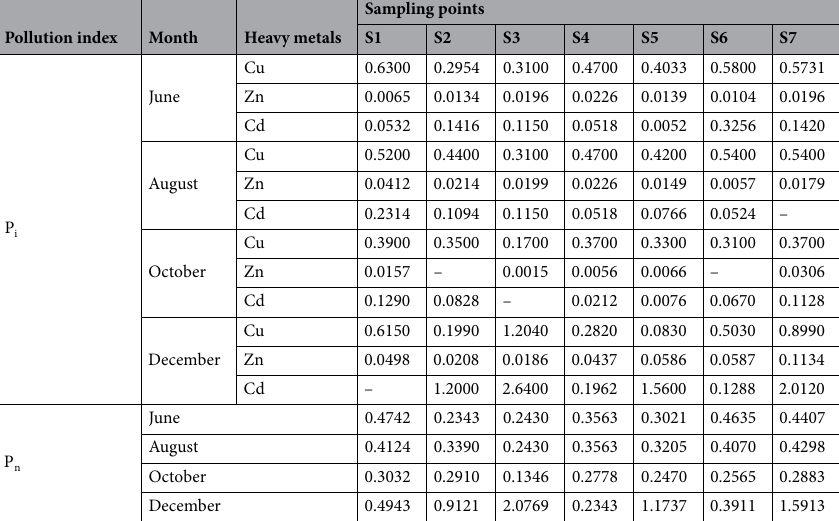
Table 2. Heavy metal pollution index. "–" indicates that the class of substances were not detected. P i is the single factor evaluation index for Cu, Zn and Cd in June, August, October and December. P n is the Nemero composite index for heavy metals in June, August, October and